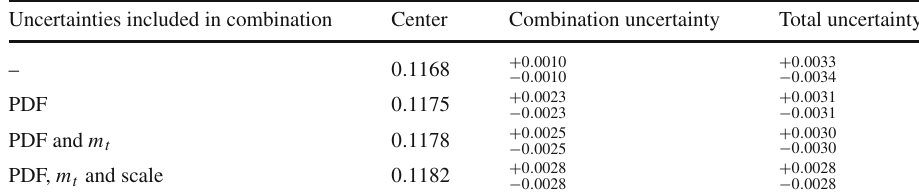
Table 14 Overview of the uncertainty coefficients for the CT14 (NNLO) PDF set. The coefficients with a δ correspond to the coefficients of the correlated uncertainty sources, and those with a (cid:5) to the uncorrelated uncertainty sources